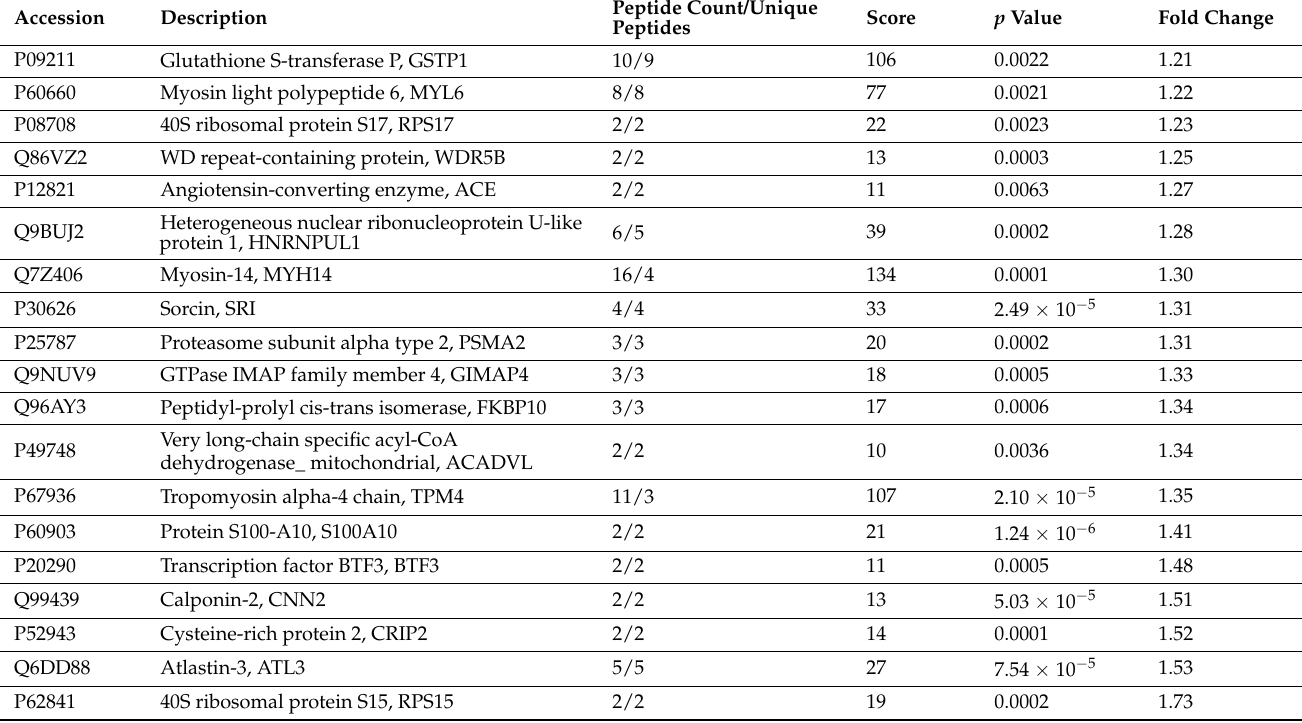
Table 1. List of the proteins identified by LC-MS E analysis and reduced by PTX3 silencing in the EC